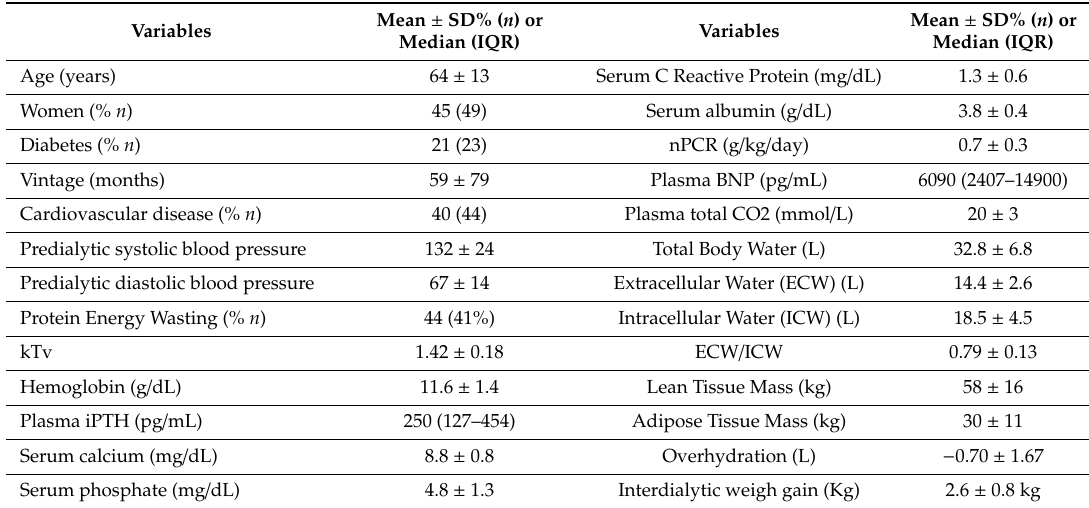
Table 1. Baseline characteristics of the 124 dialysis